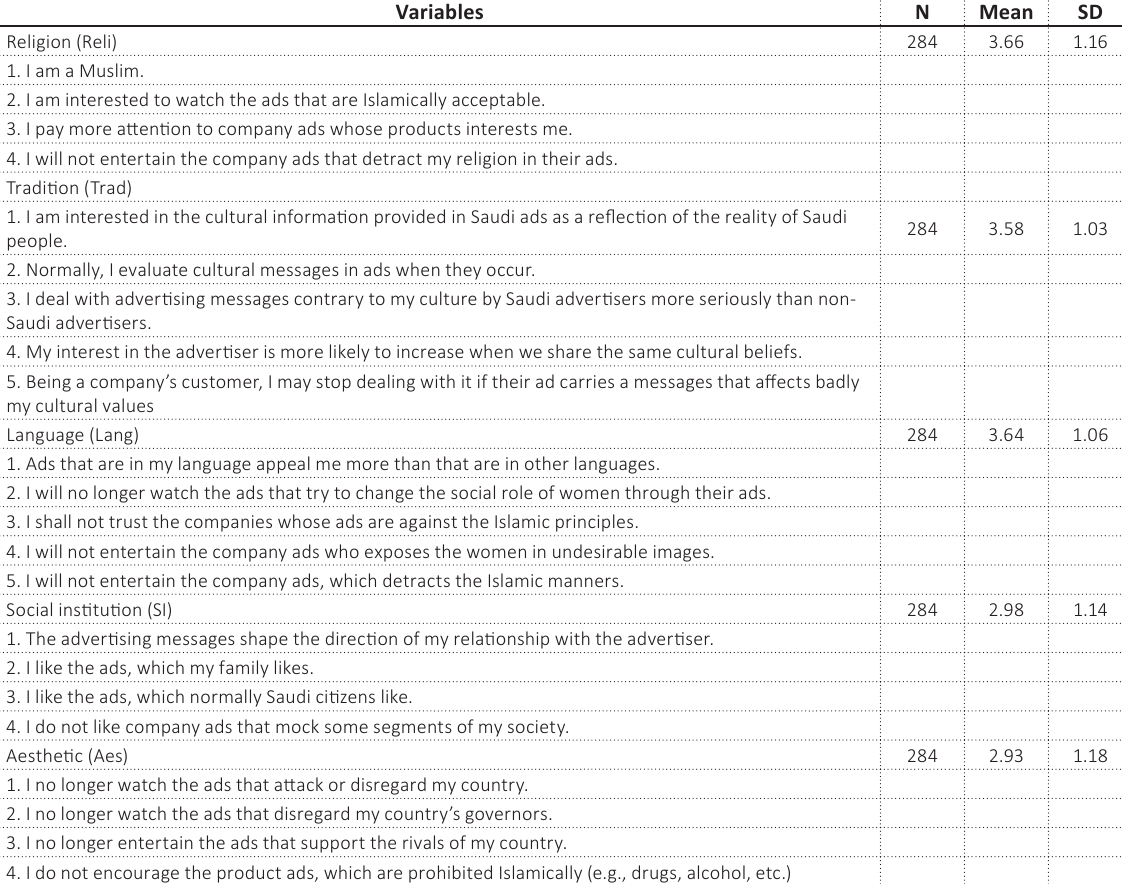
Source: Survey questionnaire adopted from Bajaber (2020).